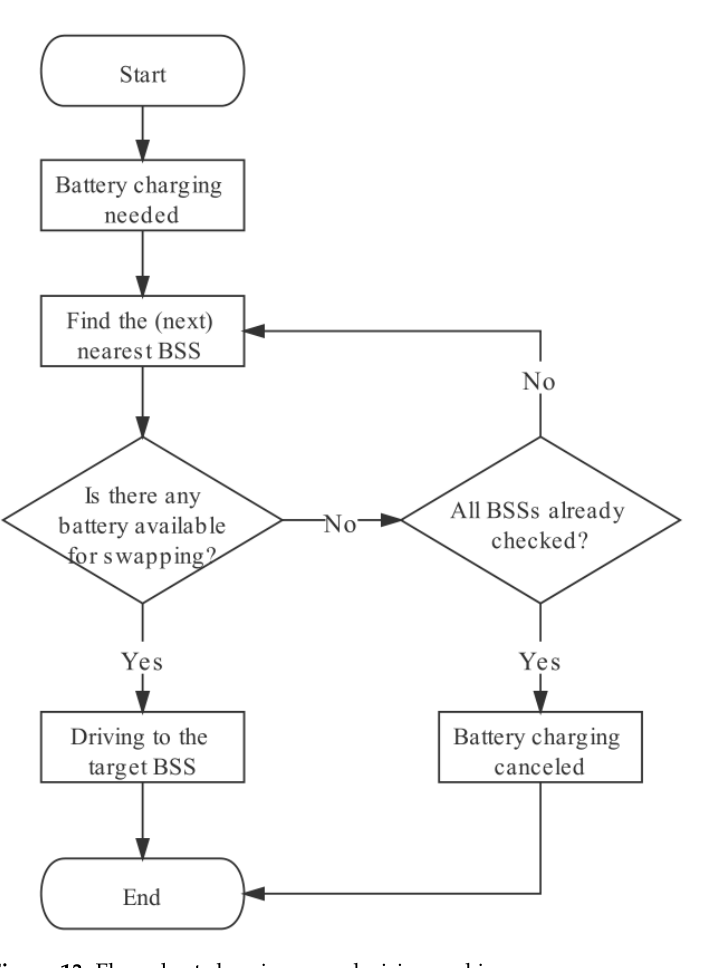
Figure 13. Flow chart showing user decision making.